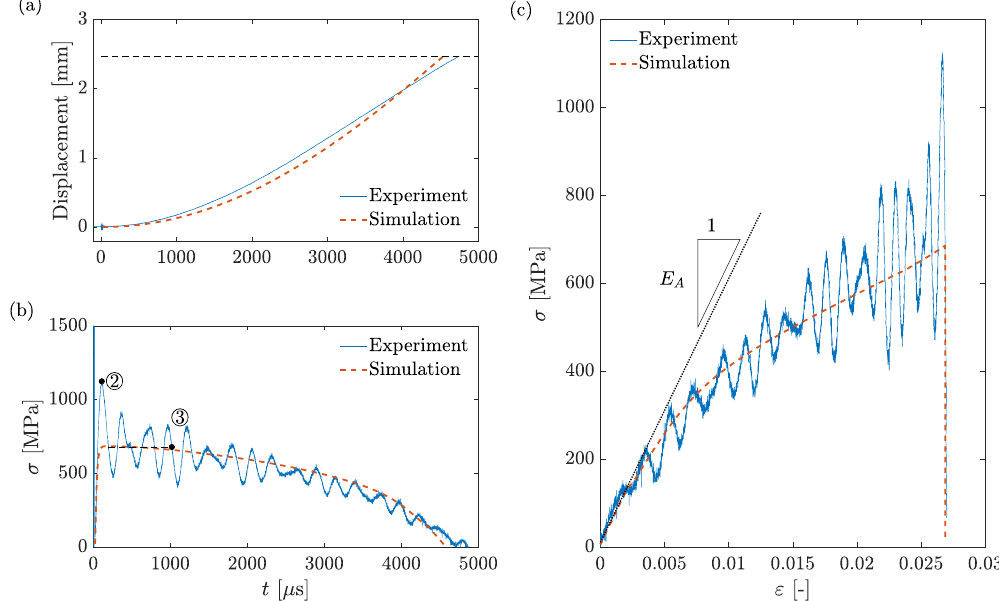
Figure 16. Comparison of experimental results with our simulation. ( a ) Time evolution of the measured and simulated displacement. The horizontal thin dashed line represents the maximal displacement of the wire due to the original strain of the detwinned martensite phase. ( b ) Stress evolution in time. The experimental solid curve oscillates around the simulated curve. ( c ) Stress-strain curves of both the experimental measurements and simulated results. The linear dotted line signifies the elastic relaxation of the austenitic wire with slope E A , corresponding to its elastic